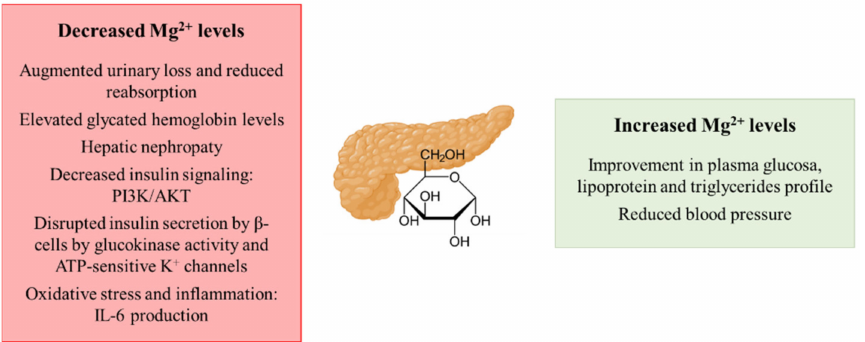
Figure 3. Schematic representation of the contribution of decreased and increased magnesium levels to the development of insulin resistance and type 2 diabetes mellitus. Abbreviations: PI3K: phosphatidylinositol-3-kinase; AKT: protein kinase